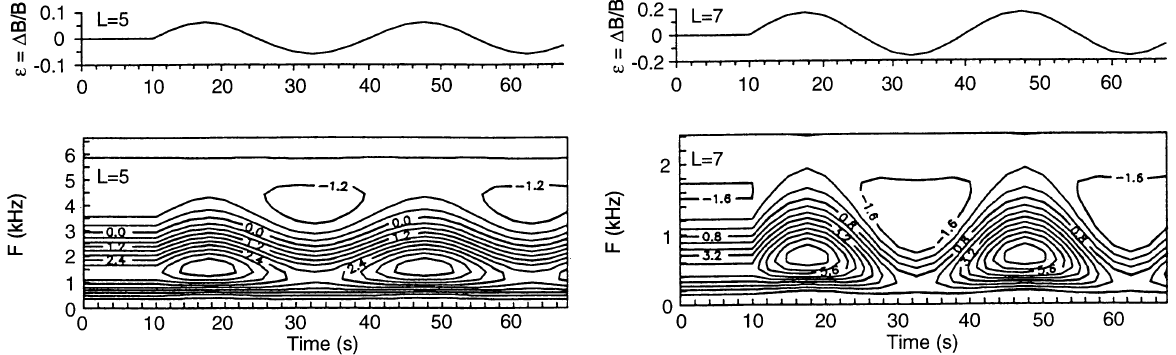
meters (cid:97)(cid:98) (cid:69) " 1, D " 1.5, n " 1 cm (cid:126)(cid:51) , (cid:97) " n / n (cid:56)(cid:33)(cid:51)(cid:46) " 10, the mag- netic-field disturbance amplitude in the VLF amplification region is 15 nT